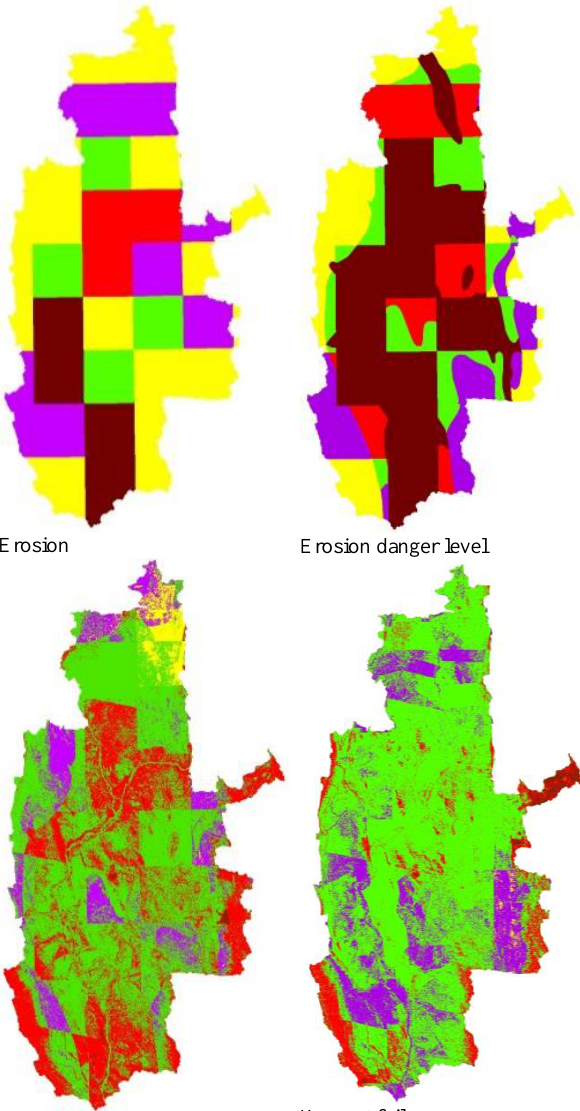
Figure 3. Thematic layers which used to generate food vulnerability map.